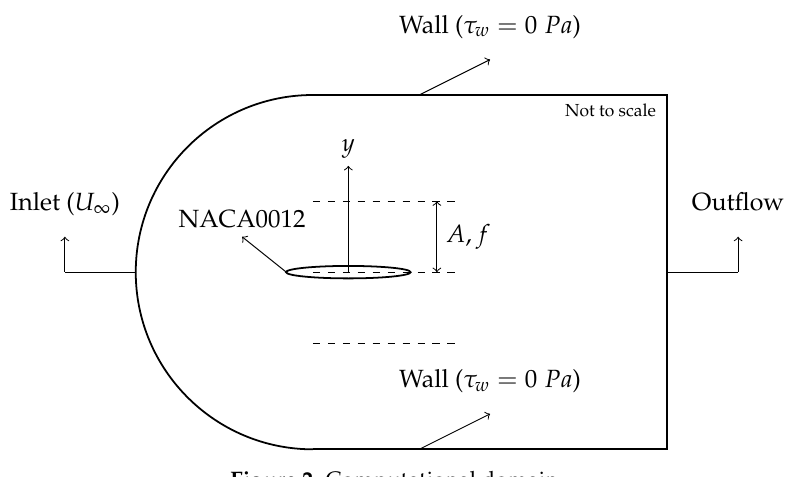
Figure 2. Computational